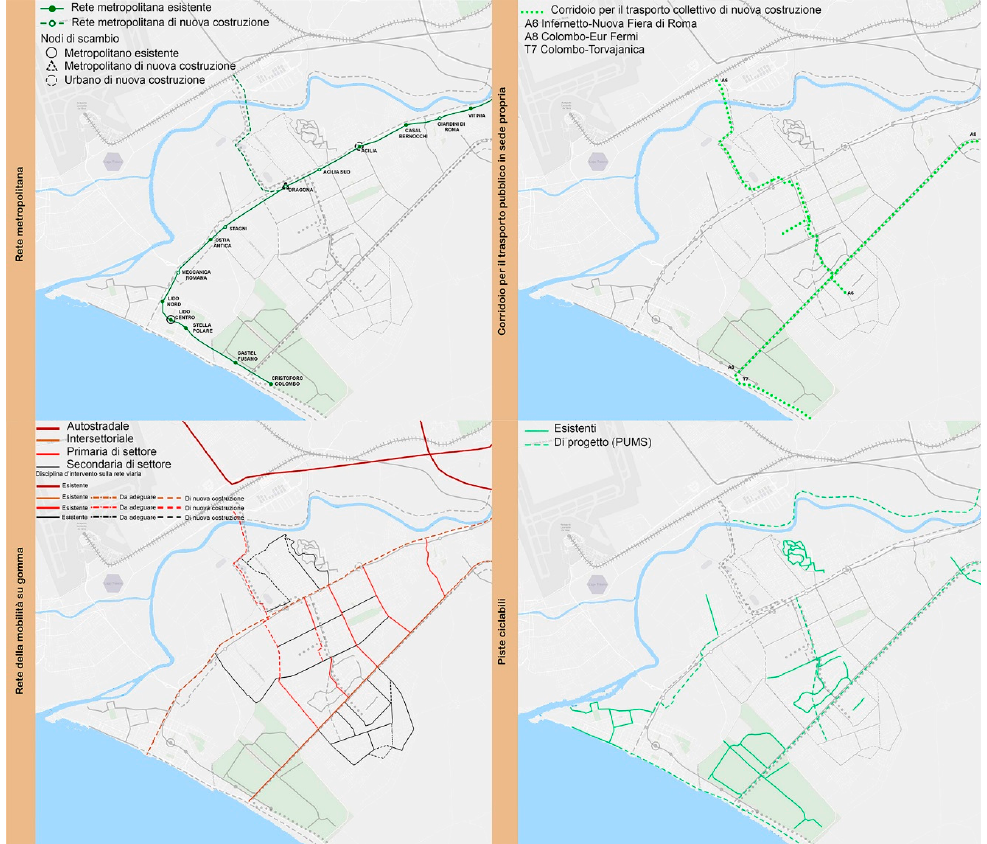
Figure 12. Rome Municipality X (Part), Local plan. System of infrastructures. Top left, underground network; top right, public transport corridors in their own premises; bottom left, road traffic; bottom right cycle ‐ pedestrian paths (Source: elaborations by the students: S. Maiorano, F. J. Moran, A. Musto, C. Paloni, Urban Planning Laboratory of the Faculty of Architecture of Rome A.A. 2021–2022).